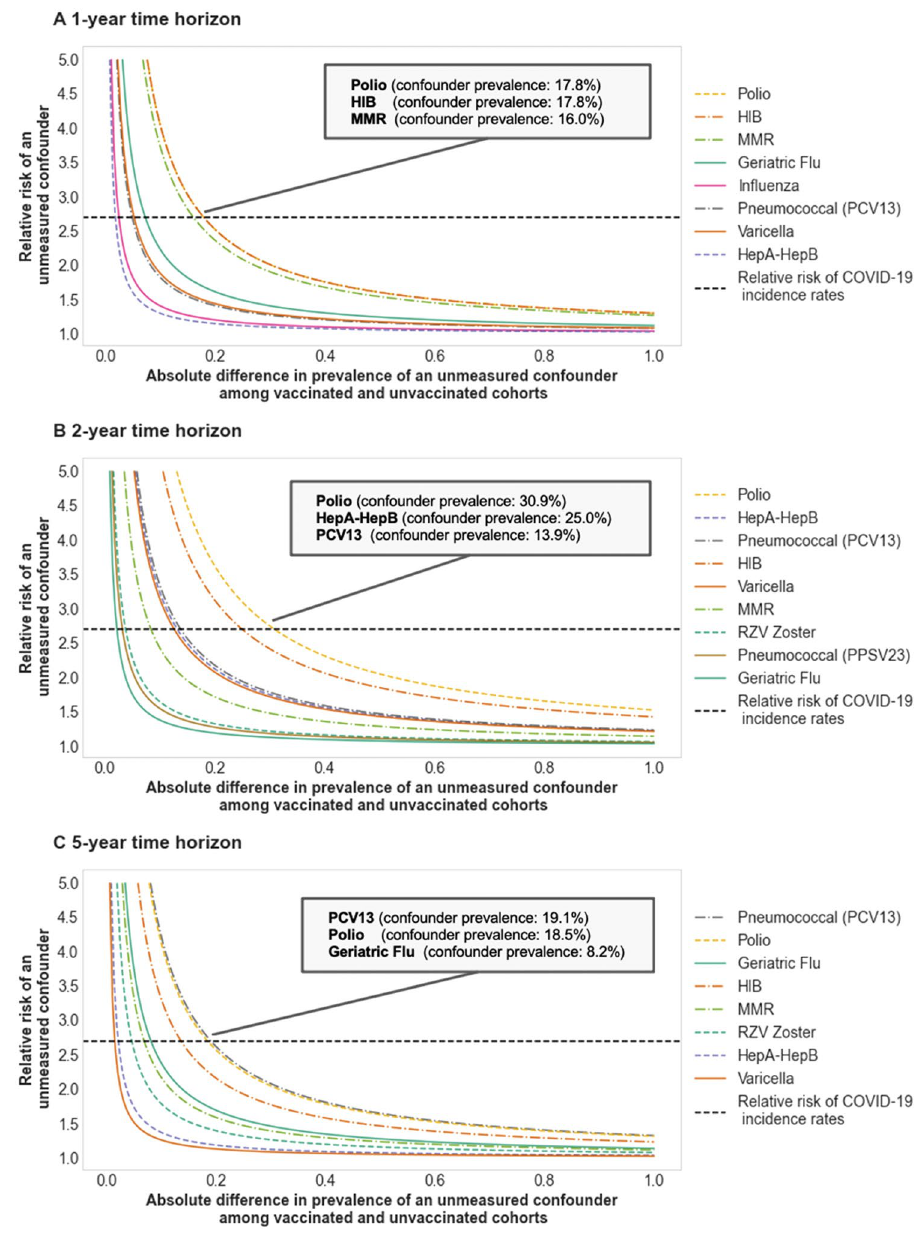
Figure 6. Sensitivity of associations between vaccines and SARS-CoV-2 rates to unobserved confounders. Tipping point analysis for associations of vaccines and lower rates of SARS-CoV-2 infection for ( A ) 1-year, ( B ) 2-year, and ( C ) 5-year time horizons. For each vaccine that is associated with lower SARS-CoV-2 rates in a particular time horizon, we plot the (prevalence, effect size) combinations of an unobserved confounder that would be required to overturn the results. The x-axis indicates the absolute difference in prevalence of the confounder between vaccinated and unvaccinated (matched) cohorts. For example, if the unobserved confounder is present in 25% of the vaccinated cohort and 5% of the unvaccinated cohort, then the absolute difference in prevalence would be 20%. The y-axis indicates the relative COVID pos risk (effect size) of the unobserved confounder. For reference, we show the relative risk of (county-level COVID-19 incidence rate ≥ median value) as a horizontal dotted line, which is equal to 2.78. Each plot is annotated with the top 3 vaccines that are most robust to unobserved confounders, along with the intersection point between the vaccine curve and the reference line. For example, for the polio vaccine at the 1 year time horizon, an unobserved confounder with a relative risk of 2.78 which is prevalent in 17.8% of the vaccinated cohort and 0% of the unvaccinated cohort could explain the differences in SARS-CoV-2 infection rates that we observe in the